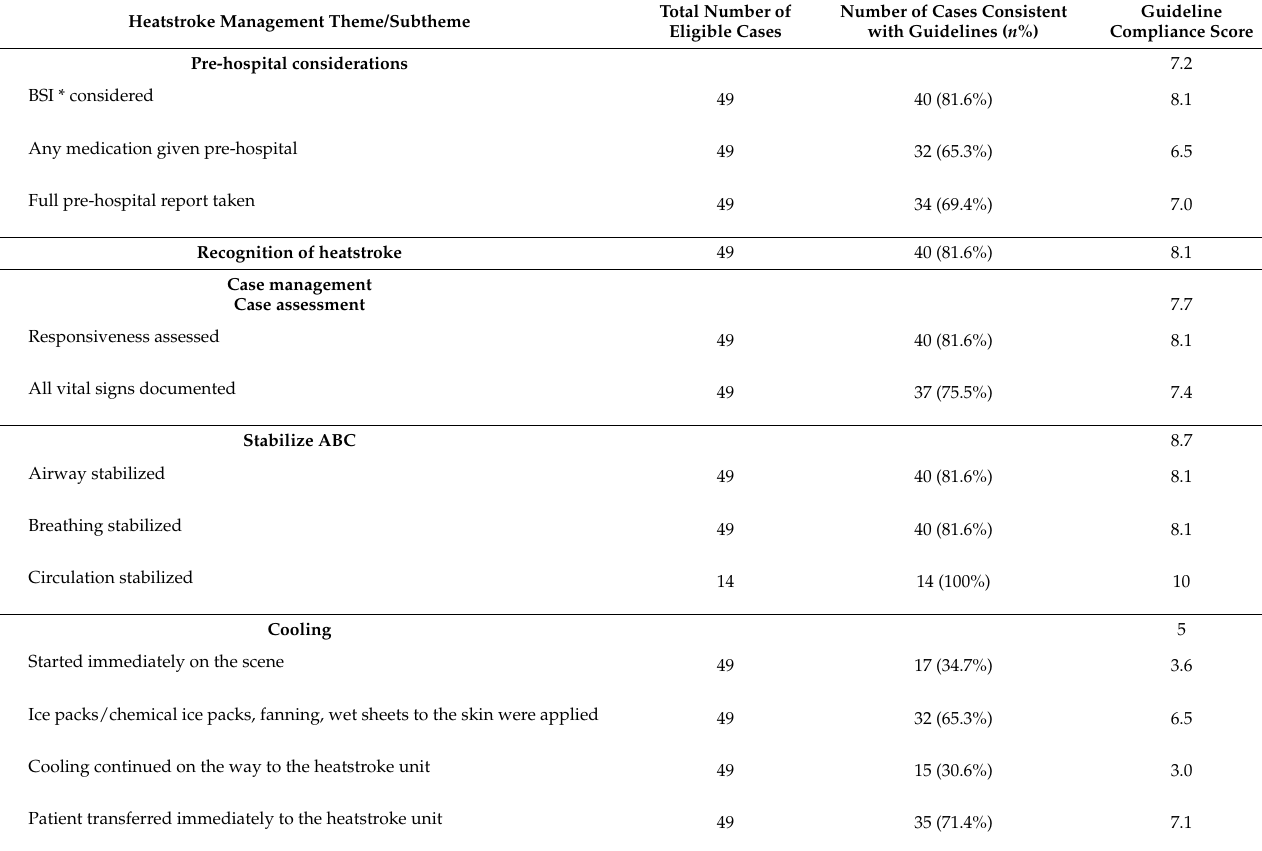
Table 3. Heatstroke pre-hospital management guidelines compliance scores ( n =